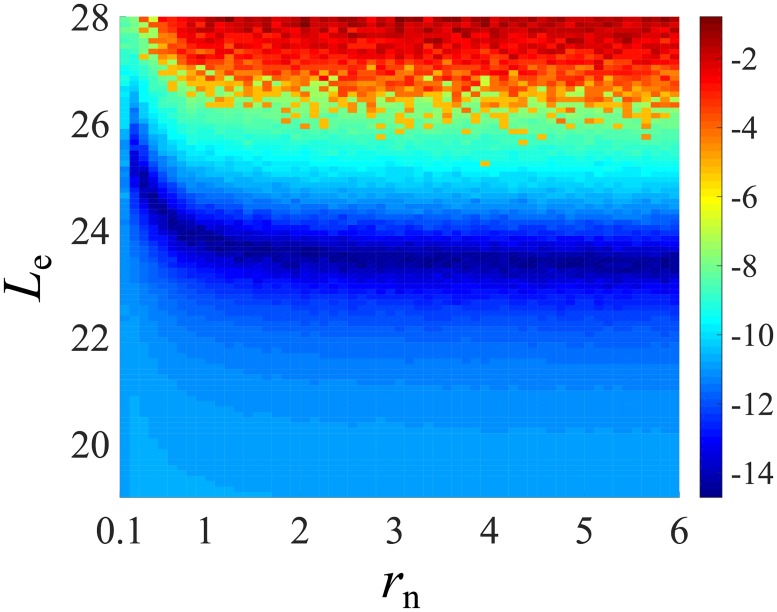
Dependence of the mean MSE defined in Eq (16) on rn and Le.For visualization purposes, we took the natural logarithms of MSE values and plotted them as a function of Le and rn. Blue areas denotes smaller MSE values, thus better fitting. This energy surface was generated by averaging over 200 simulations using Ch = 500 and λ = 0.99.